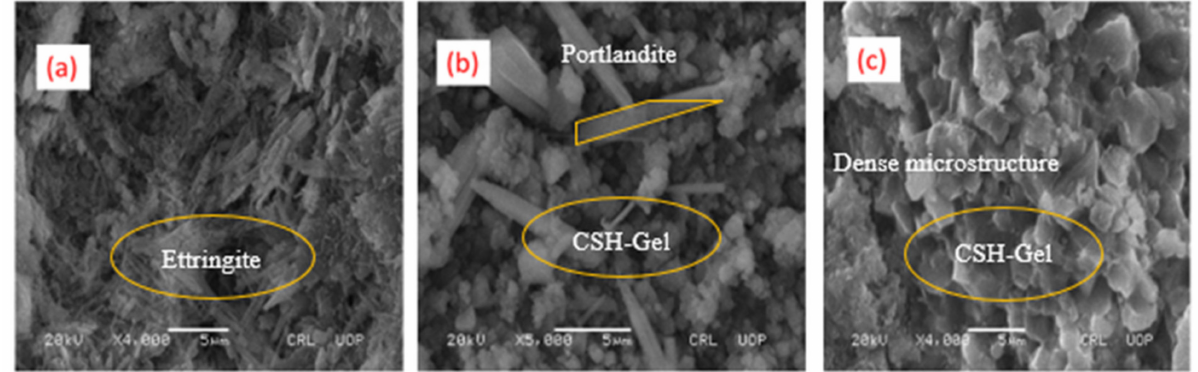
Figure 17. Scanning electron microscopy (SEM) images of self-compacting pastes at 28 days: ( a ) C10; ( b ) C90; ( c )